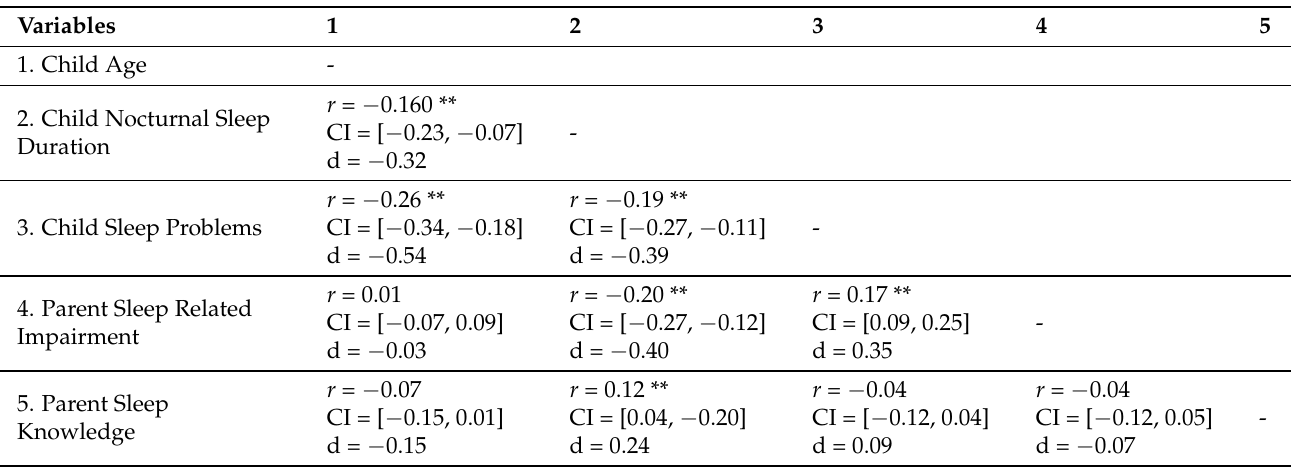
Table 4. Inter-correlations coefficients for the variables: Child Age, Child Nocturnal Sleep Duration, Parent Sleep Related Impairment and Parental Sleep